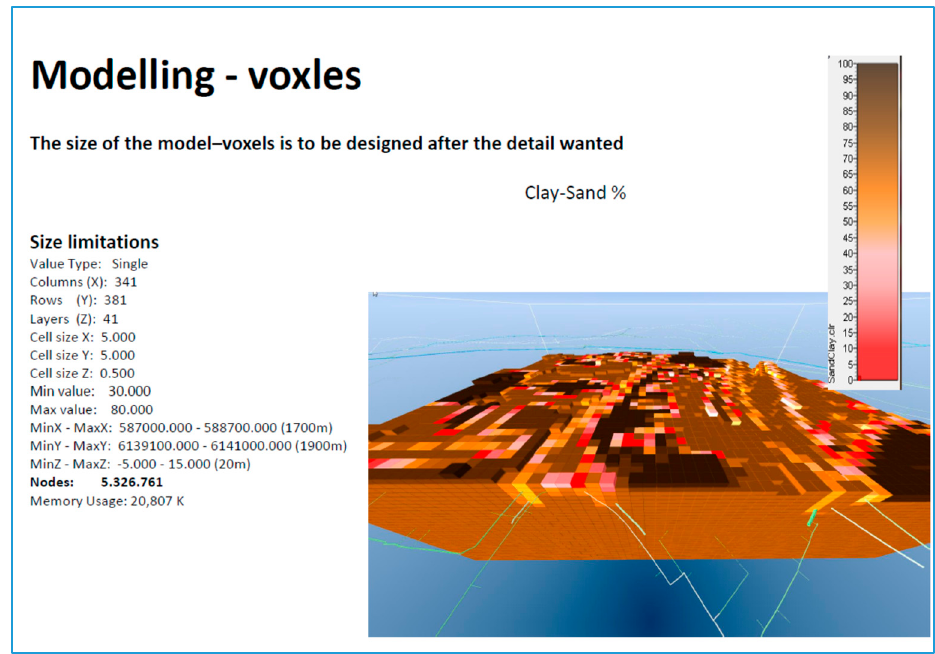
Figure 7. Visualization of detailed voxel modelling of an urban area [25,30] with buildings, and transecting boxes for roads and, pipes converted to clay-sand % and combined with different soil types.